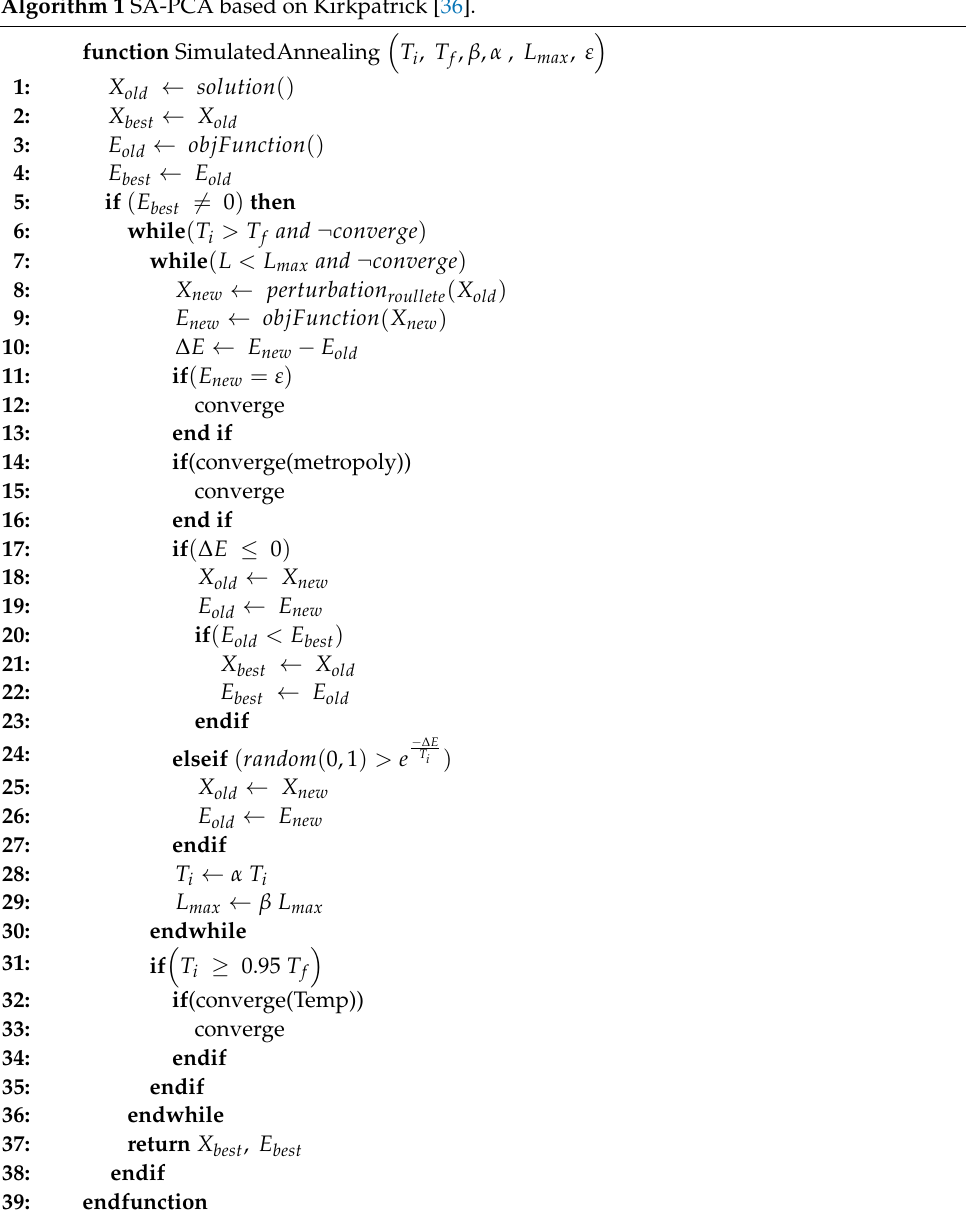
Algorithm 1 SA-PCA based on Kirkpatrick